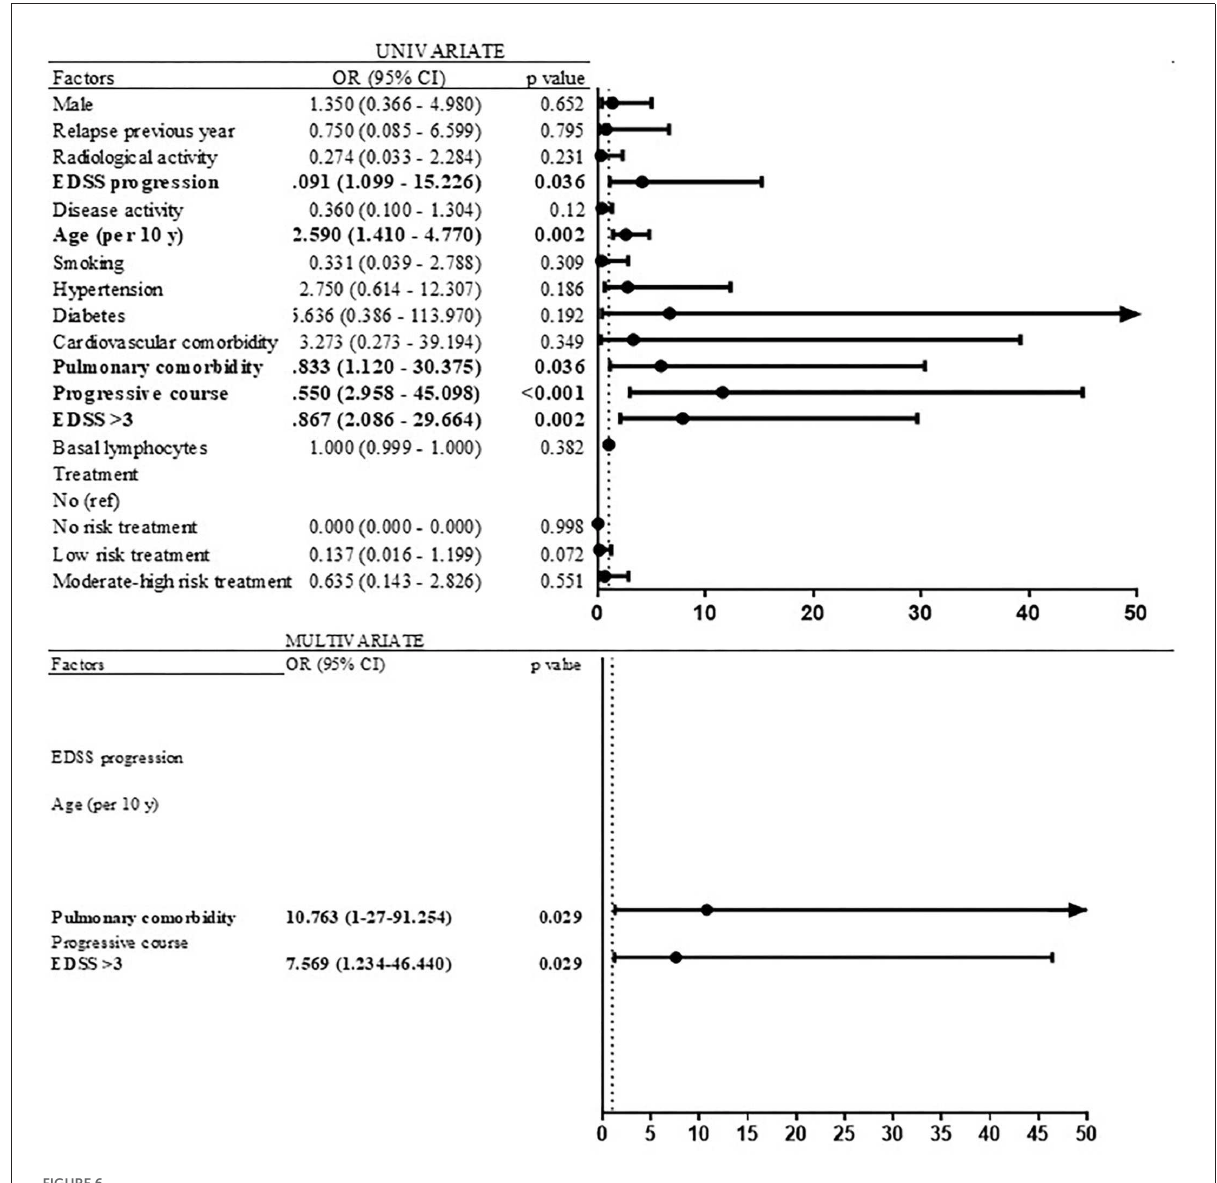
FIGURE6 Risk factors of severe COVID-19 (univariate and multivariate